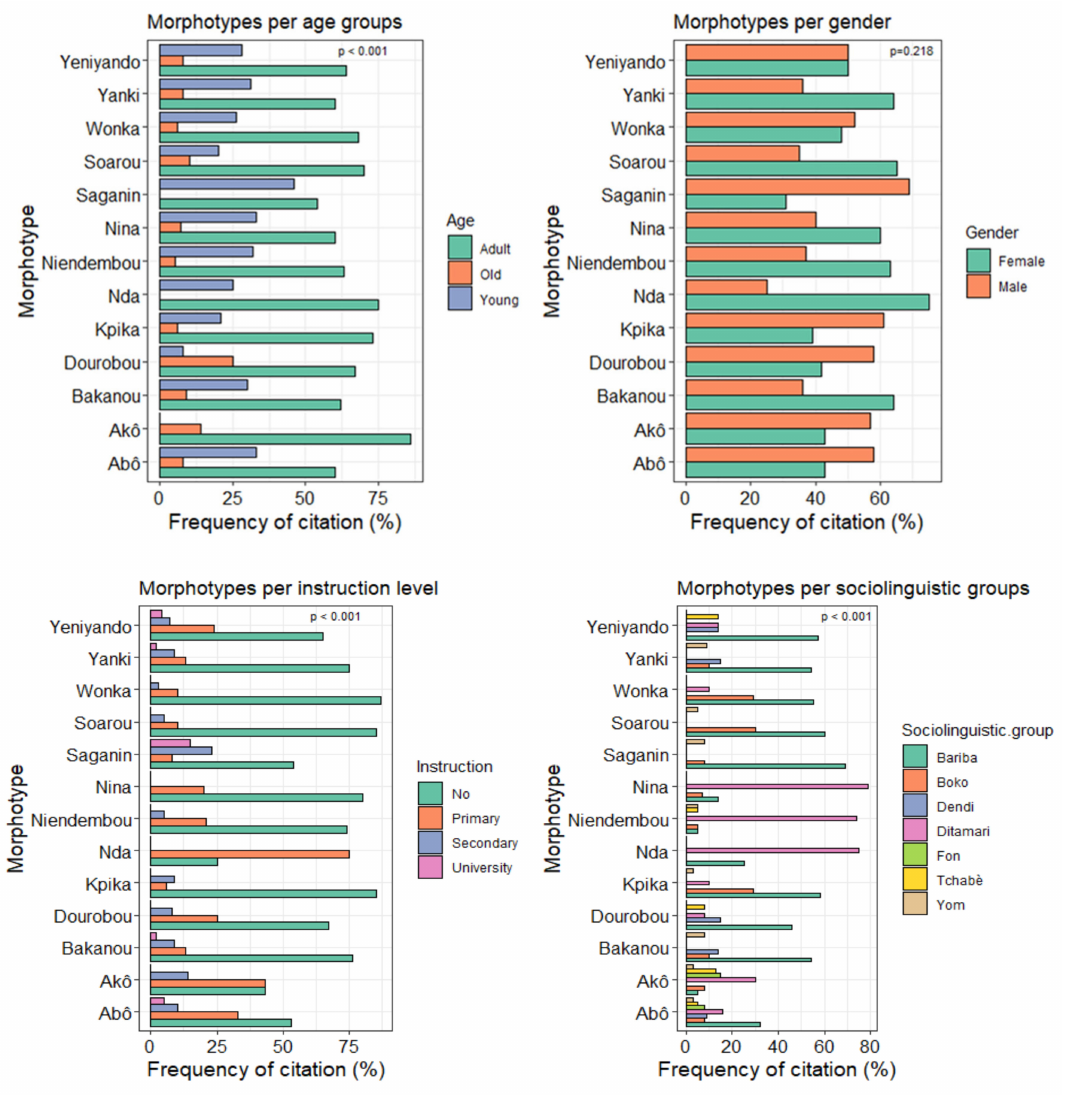
Figure 5. Relative citation frequency of the 13 main local traits according to age, gender, instruction level, and sociolinguistic